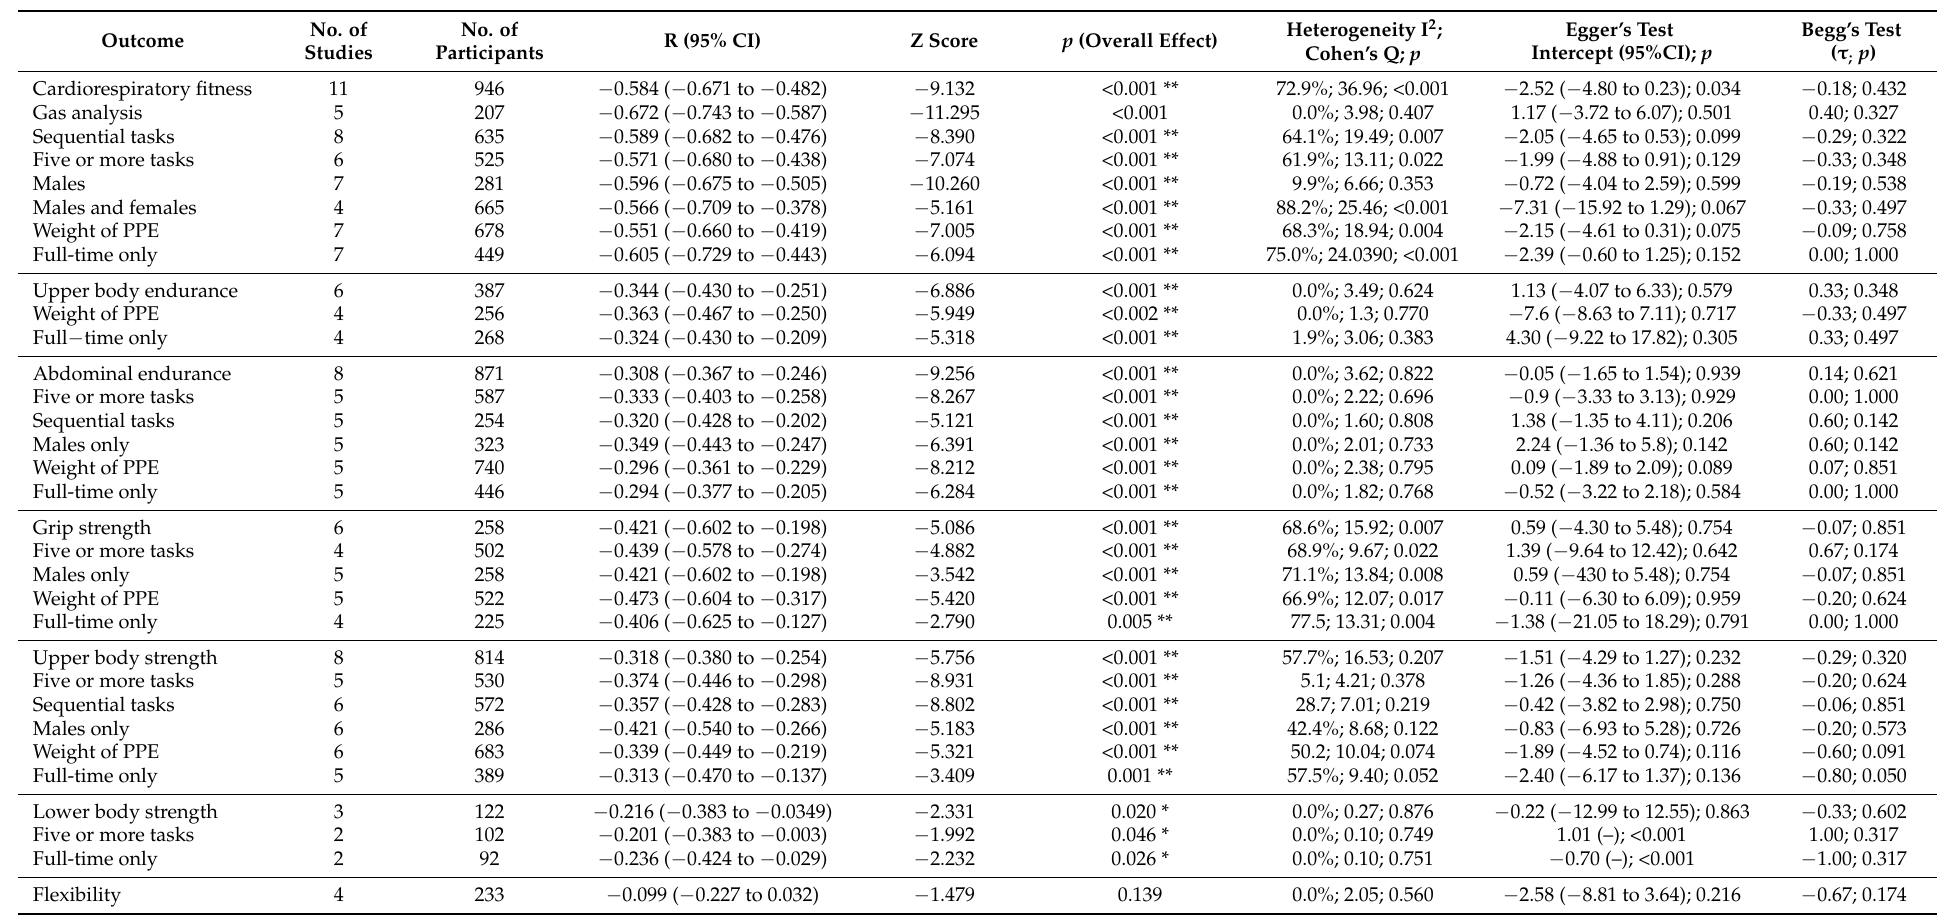
Table 5. The correlation between physical fitness and occupational performance in